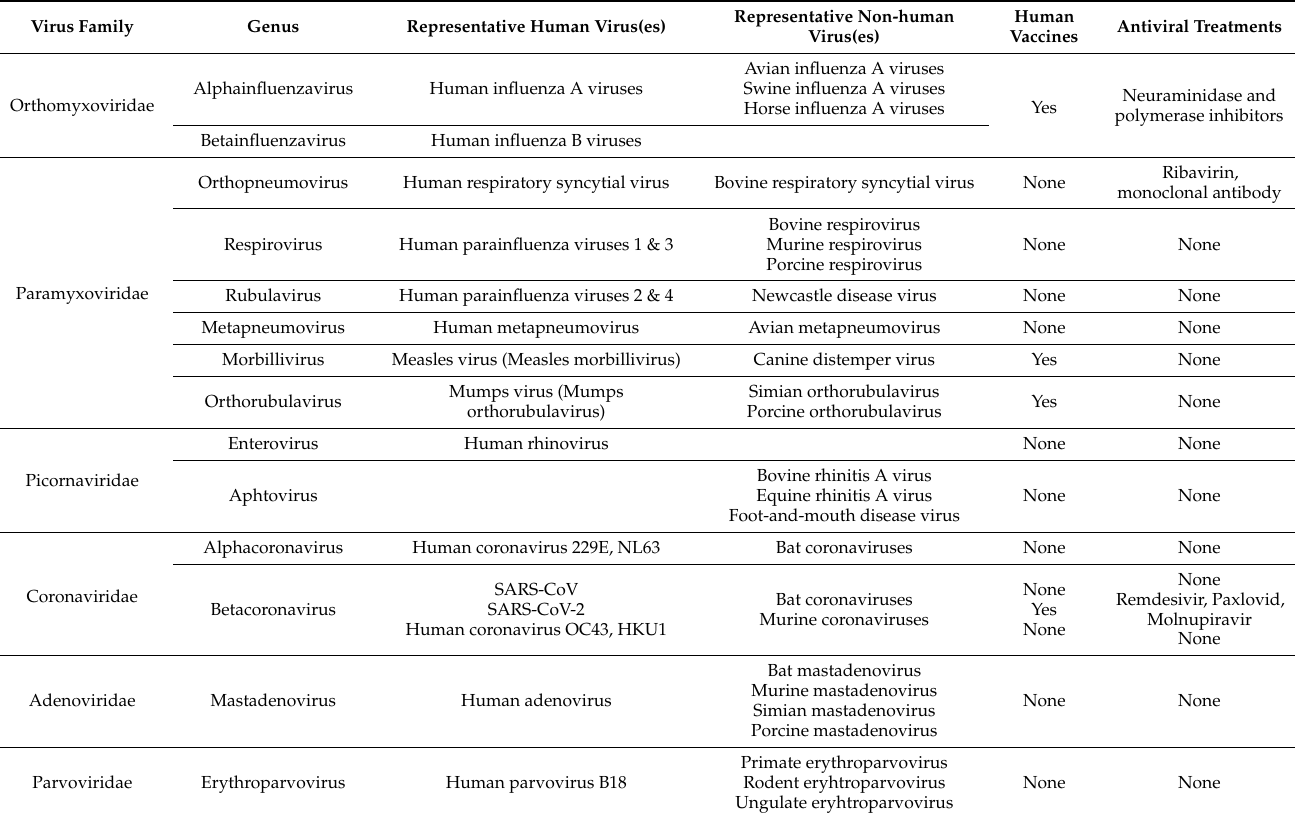
Table 2. Overview of major human respiratory